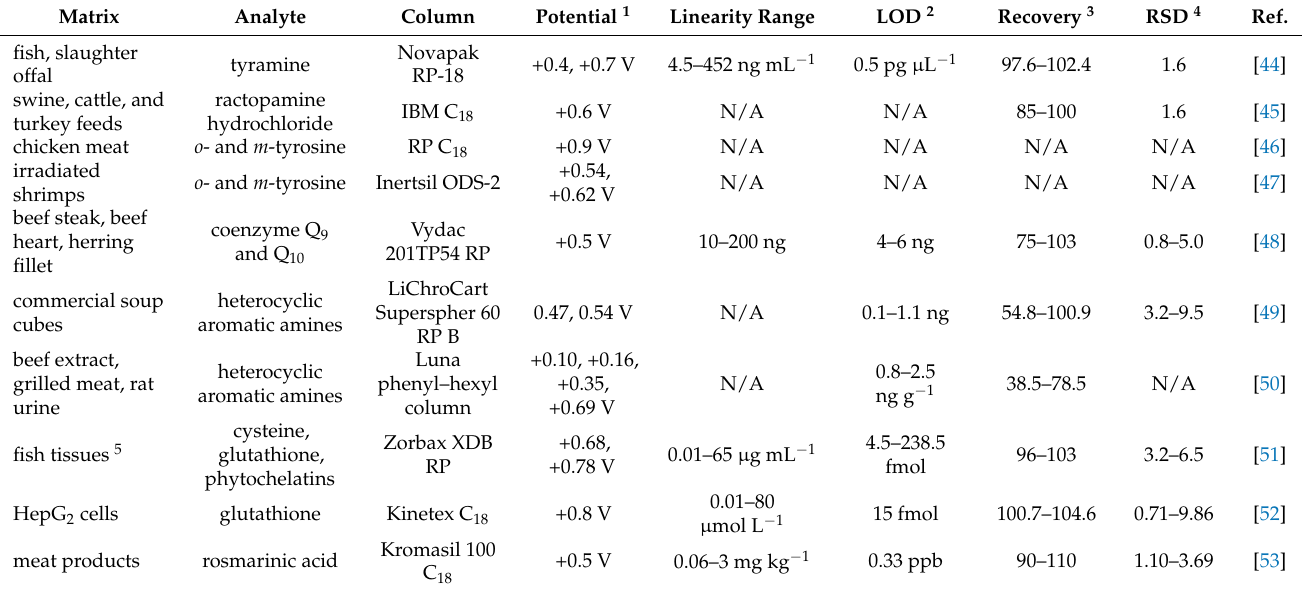
Table 2. HPLC-ED analysis performance in the analysis of different compounds in meat and fish matrices. The term “N/A” means the information is absent in the